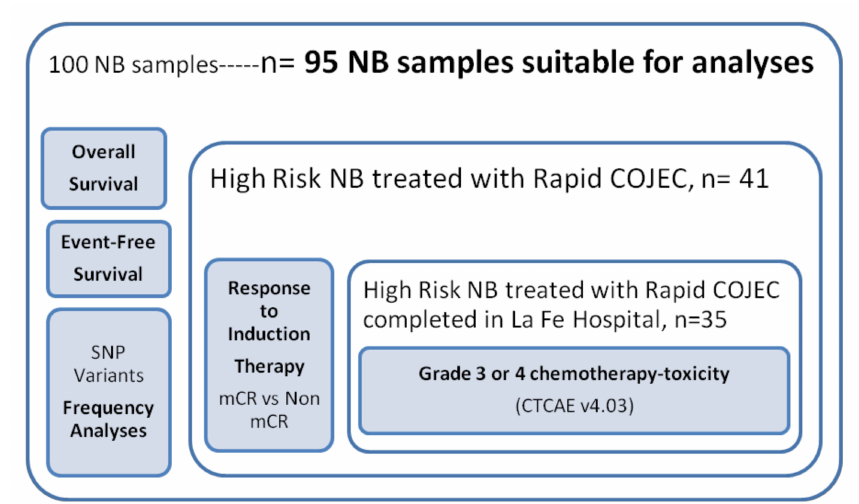
Figure 1. Patients included in the study and analyses performed. CTCAE: Common Terminology Criteria for Adverse Events; mCR: metastatic Complete Response; Non mCR: non metastatic Complete Response; NB: neuroblastoma; SNP: Single Nucleotide